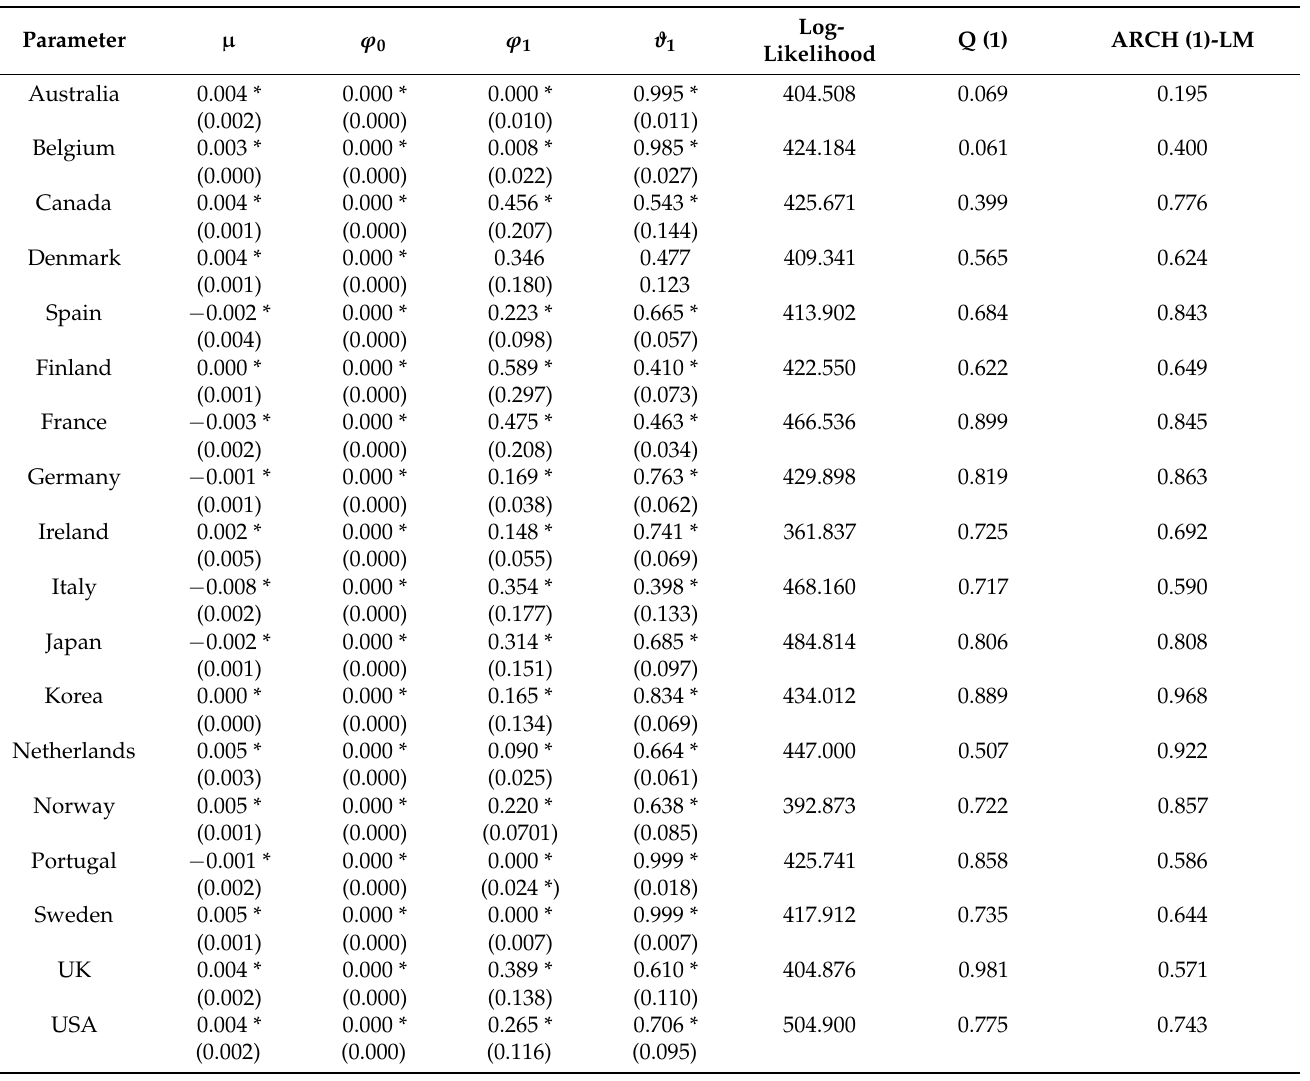
Table 8. The results of GJR-GARCH (1,1) for housing price.